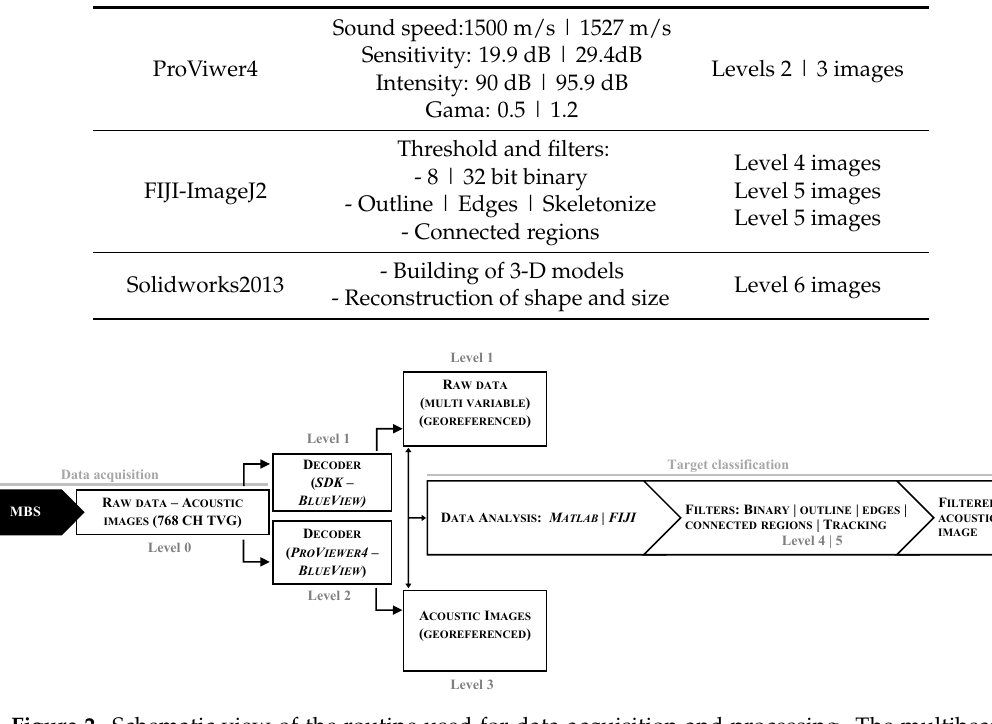
Figure 2. Schematic view of the routine used for data acquisition and processing. The multibeam sonar (MBS) raw data was firstly processed by the SDK/ProViwer4 software. The acoustic images were visualized using SDK/ProViwer4 and filtered using FIJI-ImageJ2 or Matlab2018a - Image processing Toolbox.